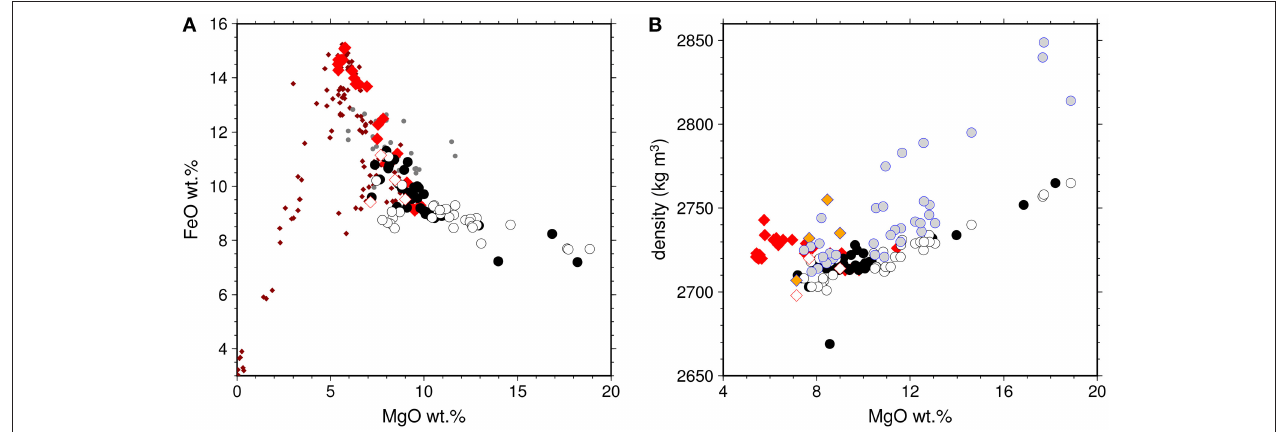
FIGURE 1 | (A) Whole-rock major element compositions of postglacial lava samples from the Theistareykir (black circles) and Krafla (red diamonds) volcanic systems. Large filled symbols show samples that are aphyric, or for which the modal macrocryst content is not recorded. Large open symbols show samples with ≥ 1 vol.% macrocrysts. Small filled symbols show whole-rock compositions of Theistareykir and Krafla lavas of glacial or unknown age. (B) Relationship between whole-rock composition and density for postglacial NVZ samples, calculated assuming that the whole-rock composition represents a crystal-free magmatic liquid. Pale filled symbols with blue outlines show magmatic densities for macrocryst-bearing samples, recalculated from the liquid and mineral densities and volume fractions according to Equation (2).